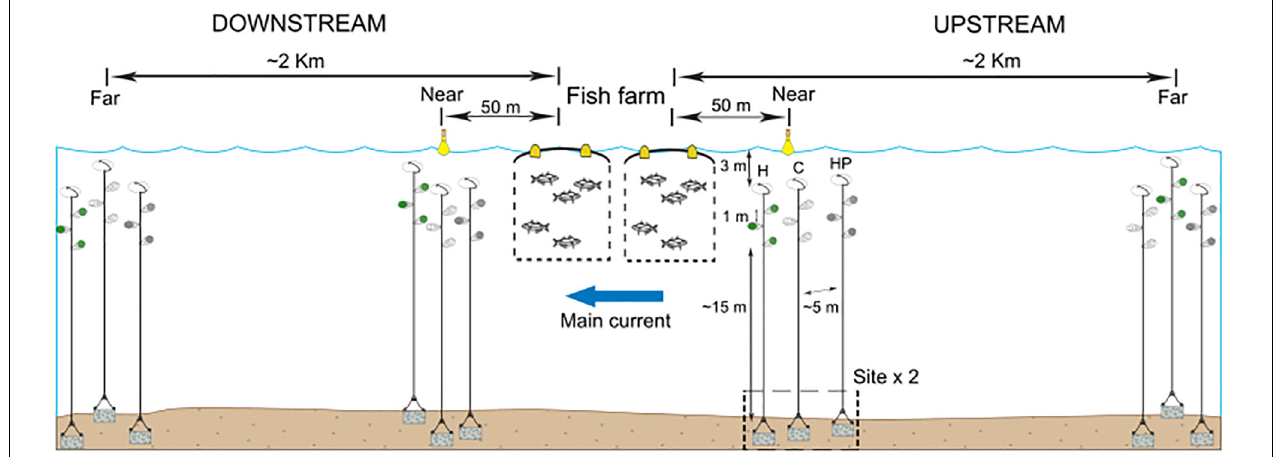
FIGURE 1 | Experimental design and scheme of the deployment of the three types of ACs containing habitat and feed pellets (HP), only habitat (H) or control (C).